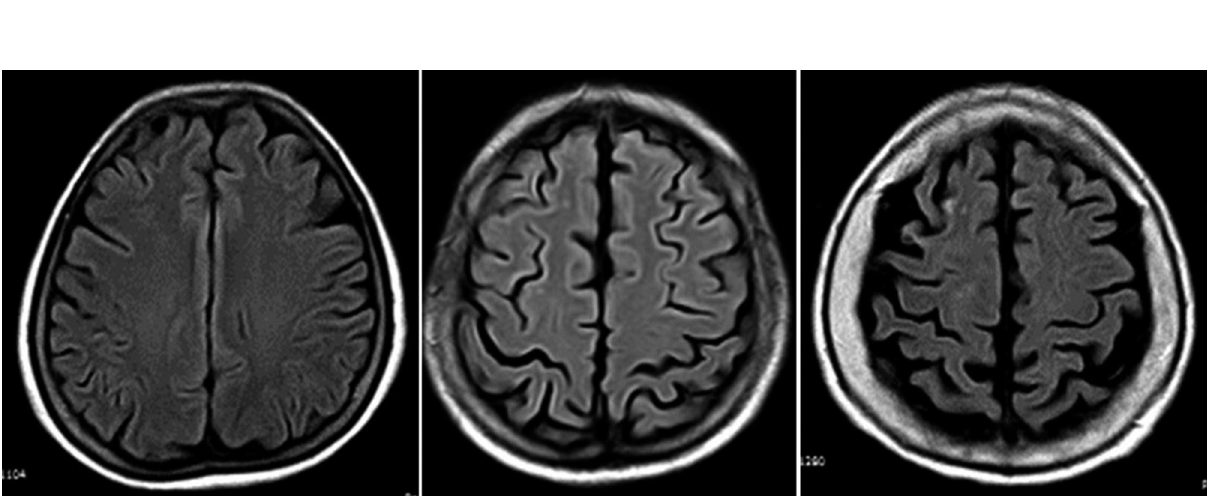
Figure 1. Fluid attenuated inversion recovery MRIs (TR 9000, TE 120, TI 2500) showing severity of global cortical atrophy (GCA) according to Pasquier et al. From left to right, columns represent mild, moderate and severe global GCA, respectively. In mild GCA there is sulcal opening peripherally, moderate GCA is characterized by widening along the length of the sulci, and severe GCA is present when there is gyral